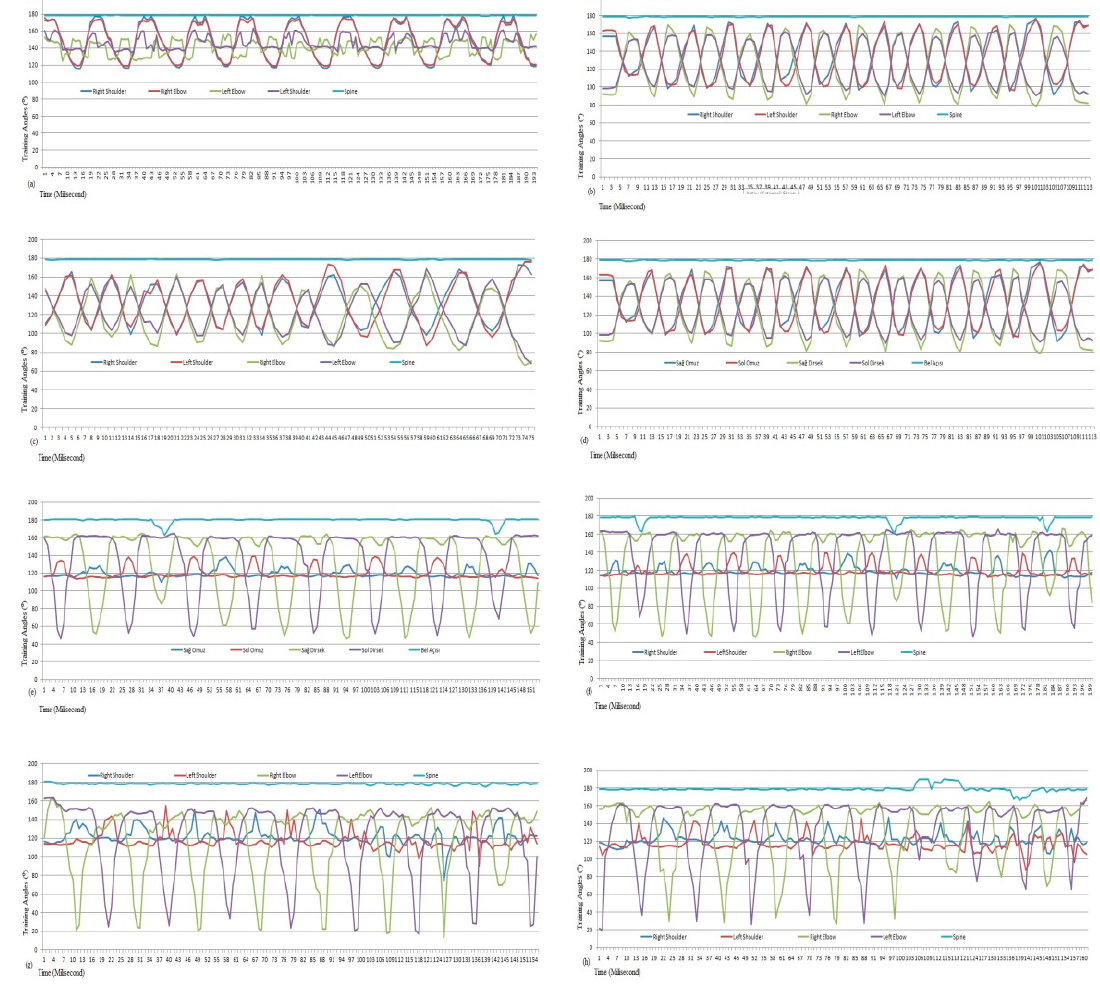
Figure 8. Data of other participants obtained from LR and DSP trainings: ( a ) results of participant number 1 for LR; ( b ) results of participant number 2 for DSP; ( c ) results of participant number 4 for DSP; ( d ) results of participant number 5 for LR; ( e ) results of participant number 7 for LR; ( f ) results of participant number 8 for LR; ( g ) results of participant number 9 for LR; ( h ) results of participant number 10 for LR.